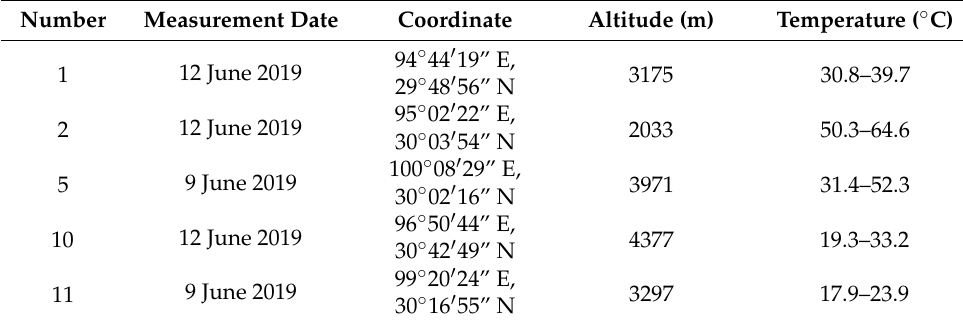
Figure 9. Verification point location and surrounding environment. ( a ) Location of verification points, ( b ) Surrounding environment of verification point 6. Table 8. Verification point